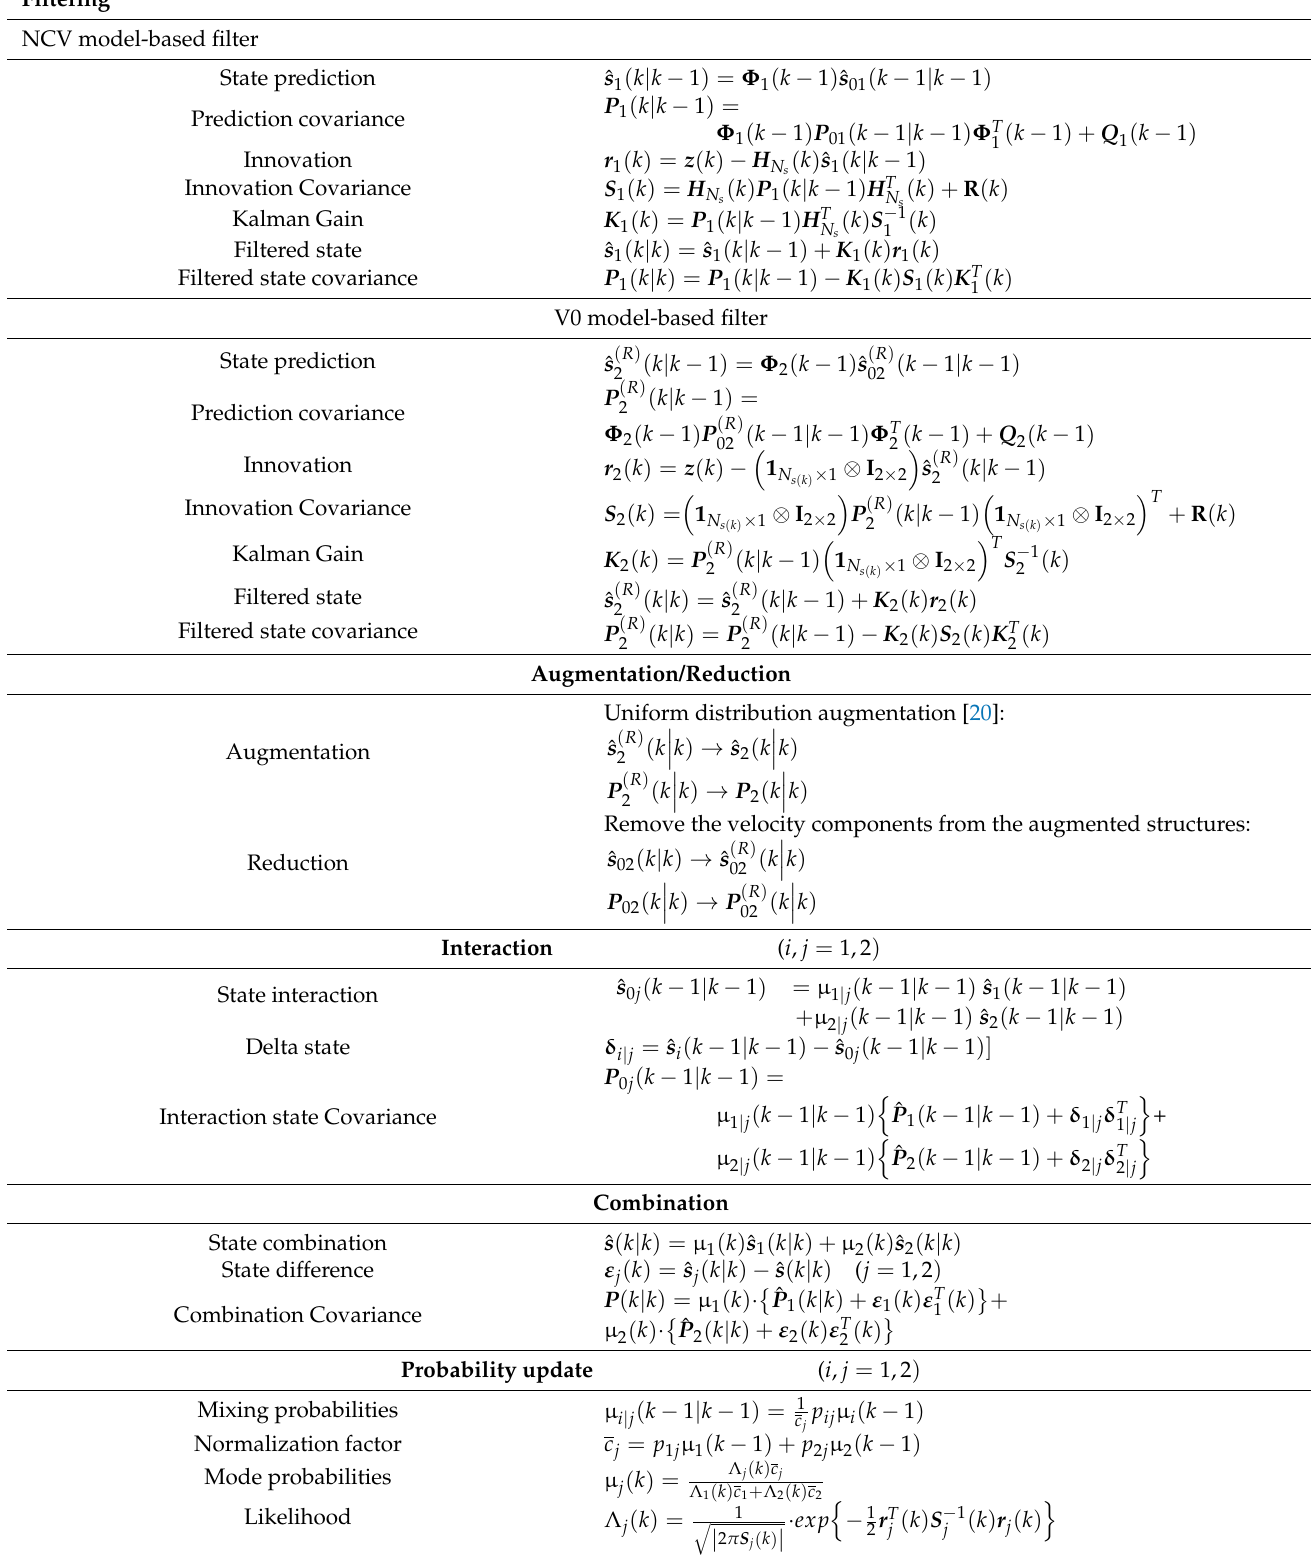
Table 2. Summary of the operations performed at each block of an IMM